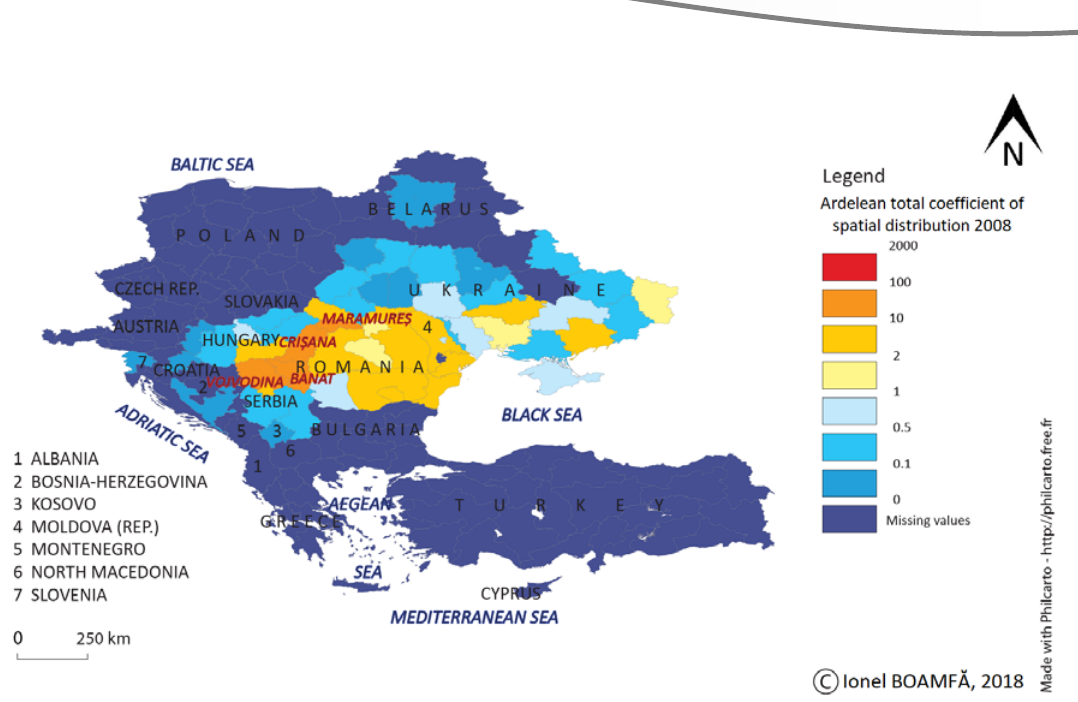
Figur e 11 . G eographical repartition of the anthroponym Ardelean. Coef. of spatial distribution The patronym Bănățean has only 102 bearers and refer s to people originating from Banat. The name is noted especially in Ardeal and Muntenia (Fig. 12), but a notable frequency is found in Vojvodina, Banat, Oltenia and Transnistria as well. 10